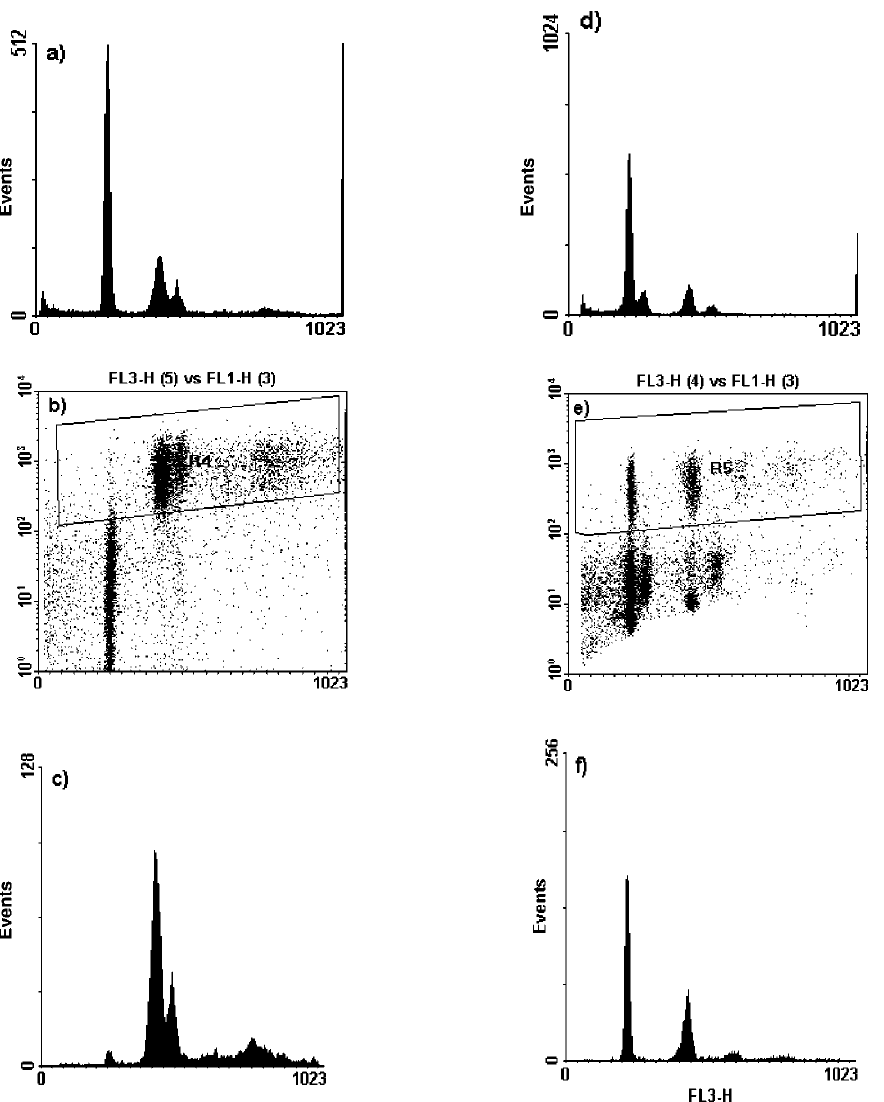
Fig. 6. Examples of bivariate CK7/DNA FCM analyses in superficial transitional cell carcinoma. Ungated DNA histograms (a, d), dot-plots (b, e) and DNA histograms after gating with cytokeratin 7 (c, f); (a) DI = 1.67 + 1.90; (d) DI = 0.88 CK-labelled cells were gated to generate histogram (c) and (f) from the epithelial component